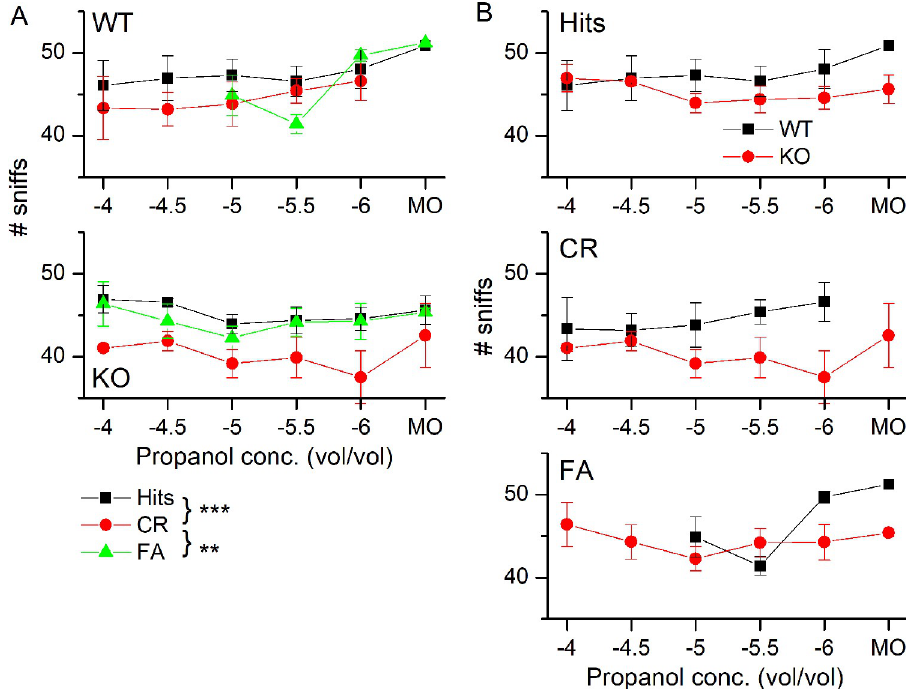
Fig 5. Number of sniffs taken during odorant sampling. A Comparison of the total number of sniffs taken during the five 200 ms bins centered on 0.5 to 1.3 s in WT (top) and NCKX4 KO (bottom) mice for Hits, CRs and FAs. B Comparison of Hits, CRs and FAs between the WT and the KO. The number of sniffs has behavioral outcome as the only predictor in the final model with it being the main significant effect (F = 13.97, p = 6.127e -06 ), and post-hoc comparisons (Tukey) show that the number of sniffs for CRs is significantly less than that of FA (p = 0.0099) and Hits (p < 0.0001). Data points are averages ± SEM of 3 WT and 3 KO mice. The x-axis displays the log of the odorant